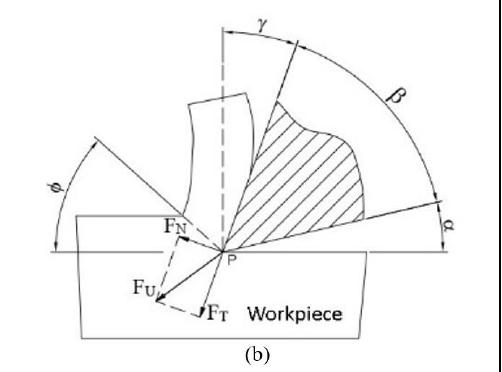
Figure 1b: Machining force components in the work plan: b) frictional force (F T ) and normal force to the output surface (F N ). Source: Adaptation by [11].